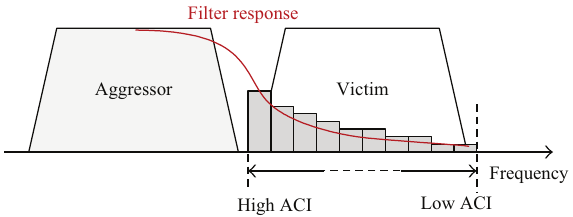
Figure 4: Conceptual example of adjacent channel interference caused by